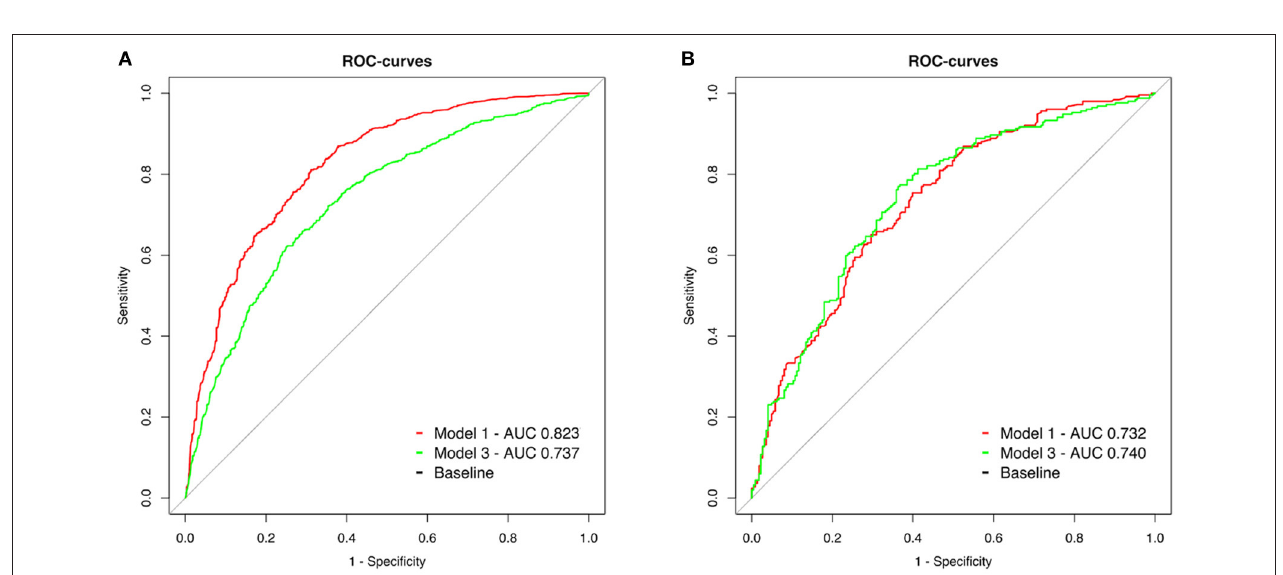
FIGURE 2 | (A,B) Receiver operating characteristic (ROC) curves of two models to predict 30-day neurological outcome. Model 1 (red line): Inclusion of peri-arrest factors (age, sex, witness status, and BLS, shockable initial rhythm, cumulative adrenaline). Model 2 (blue line): model 1 combined with the parameters from the initial blood gas analysis (pH, lactate level, and base deficit). OHCA: out of hospital cardiac arrest, IHCA: in hospital cardiac arrest.